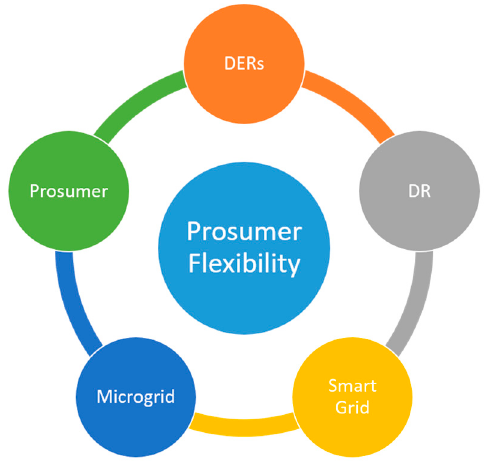
Figure 11. Key issues identified from the literature.